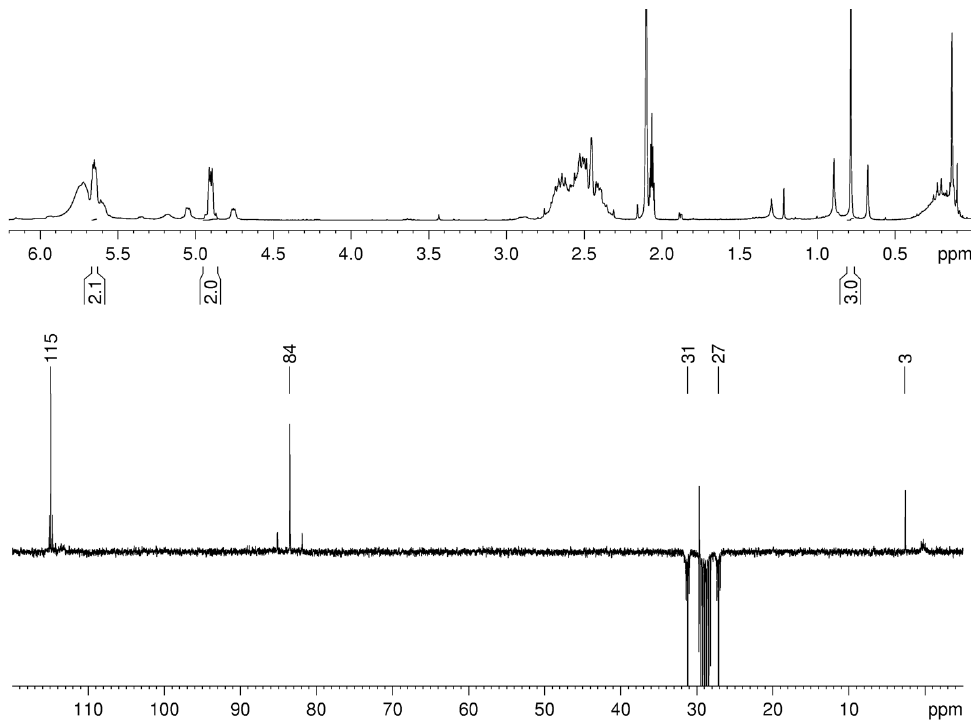
O)] + in acetone-d 6 . The broad signal at 2